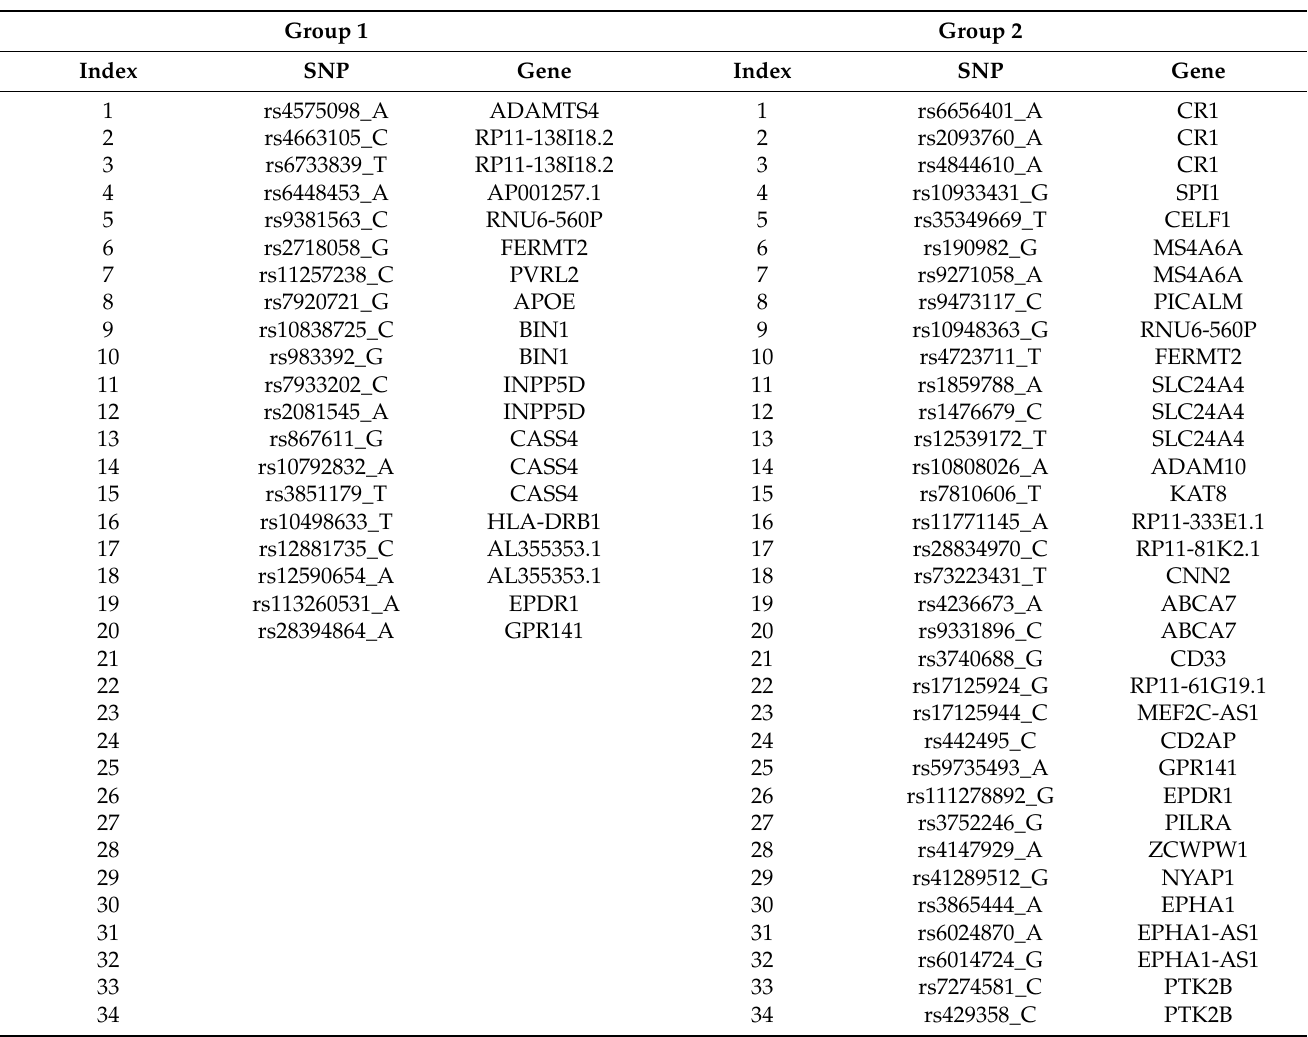
Table A4. SNP clustering result on the AV45 measures for the LMCI vs. HC comparison. The SNP and the corresponding closest genes are listed for each resulting cluster or group.